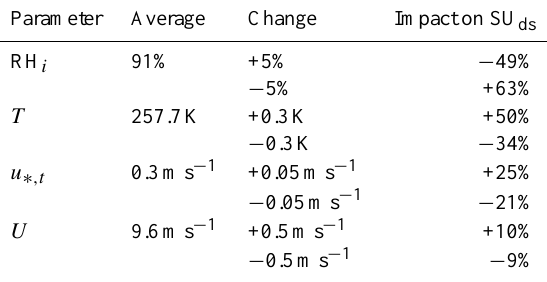
Table 2. Sensitivity of annual accumulated SU ds (% change com- pared to default value) to systematic changes of different sur- face variables. These adaptations are applied to 1yr of simula- tion (1997). The original SU ds amount in 1997 is 70mm. Parameter Average